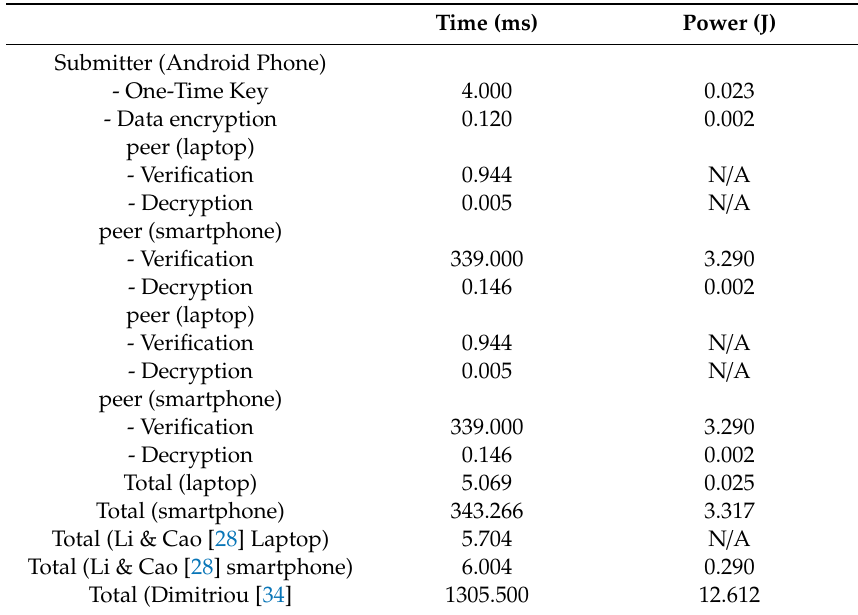
Table 2. Resource consumption of cryptographic